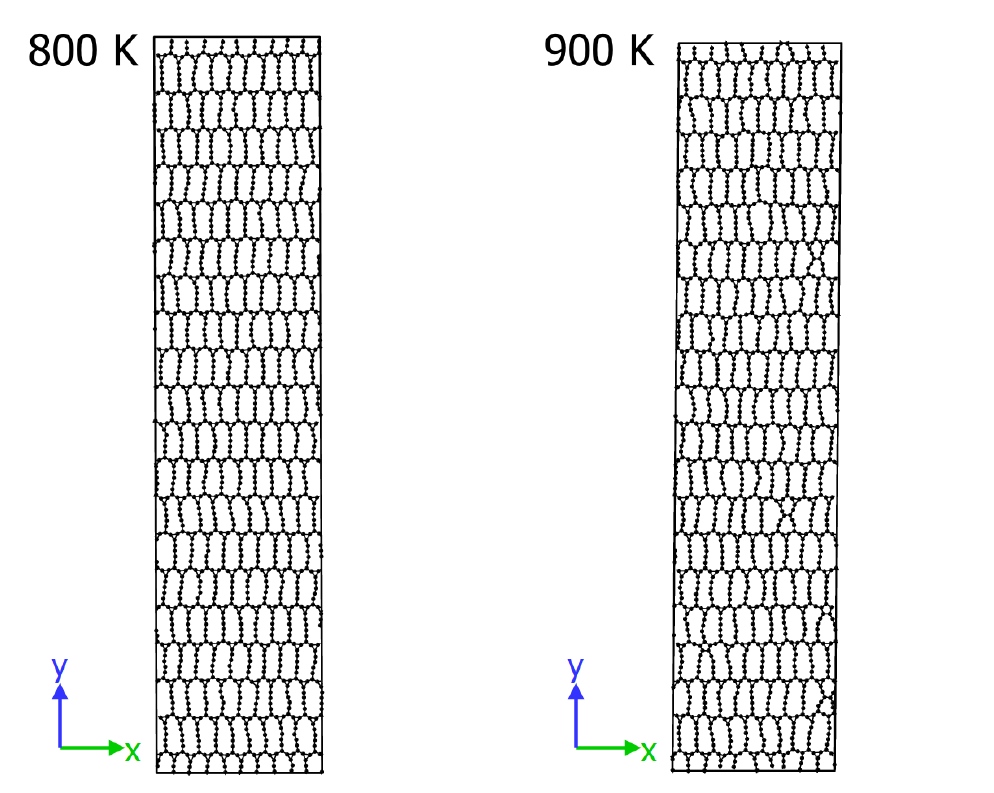
Figure 7. Anisotropic-cyclicgraphene —snapshots of the structures at 800K and 900K after